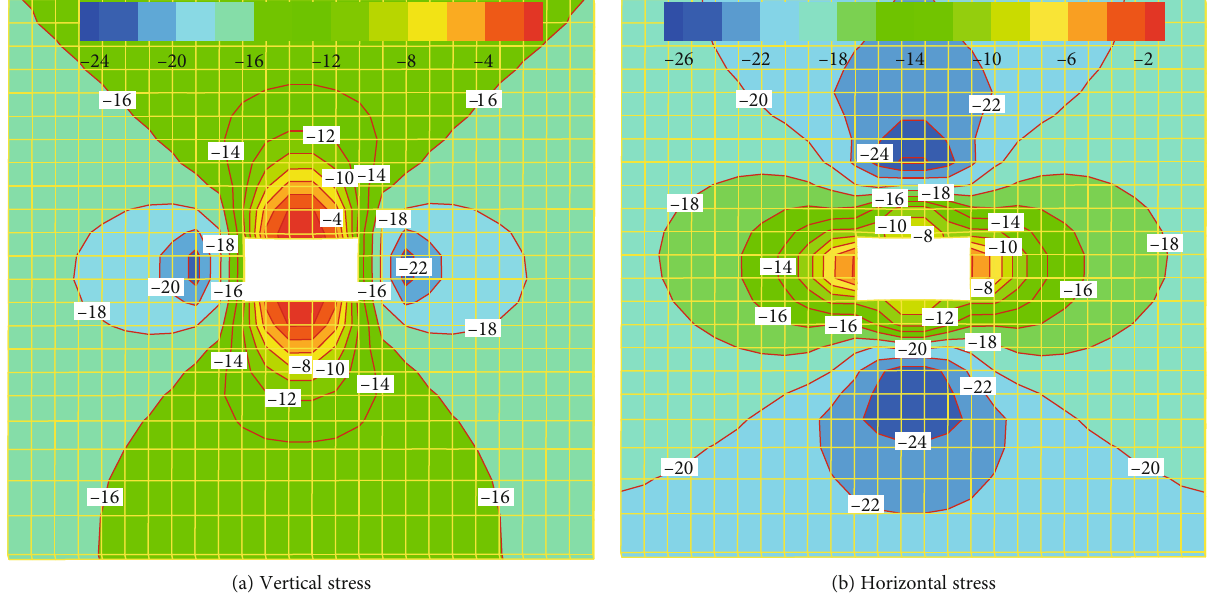
Figure 10: Stress fi eld distribution law of surrounding rock in gas drainage roadway with fl